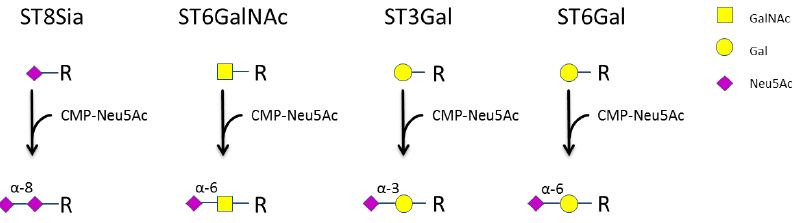
Figure 1. Groups of human sialyltransferases. Sialyltransferases catalyze the transfer of N-acetylneuraminic acid (Neu5Ac) to N-acetylgalactosamine (GalNAc), galactose (Gal) or other Neu5Ac molecules.